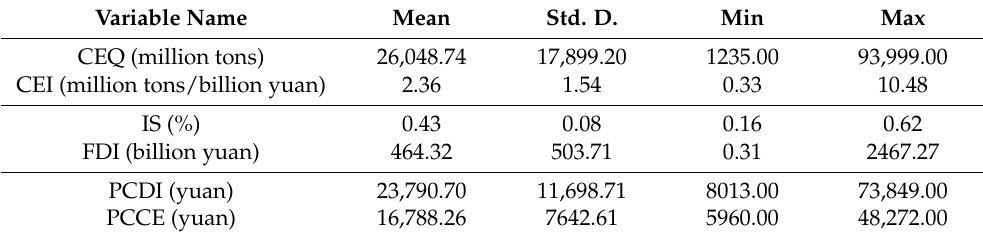
Table 2. Descriptive statistics of